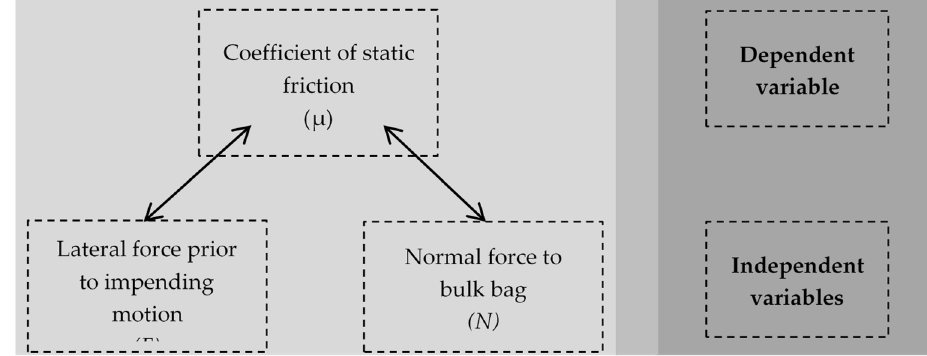
Figure 4. Inter-relationship between main dependent and independent variables.